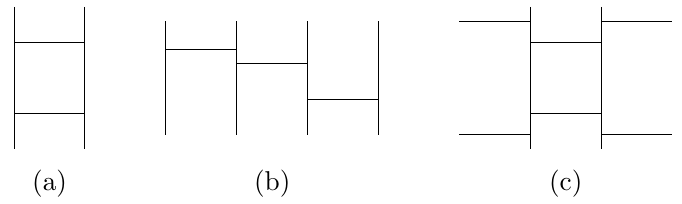
Figure 3 . Examples of simpli(cid:12)ed webs: (a) SU(2) gauge theory, (b) A 3 quiver U(1) gauge theory, (c) SU(2) gauge theory with four (cid:13)avors.